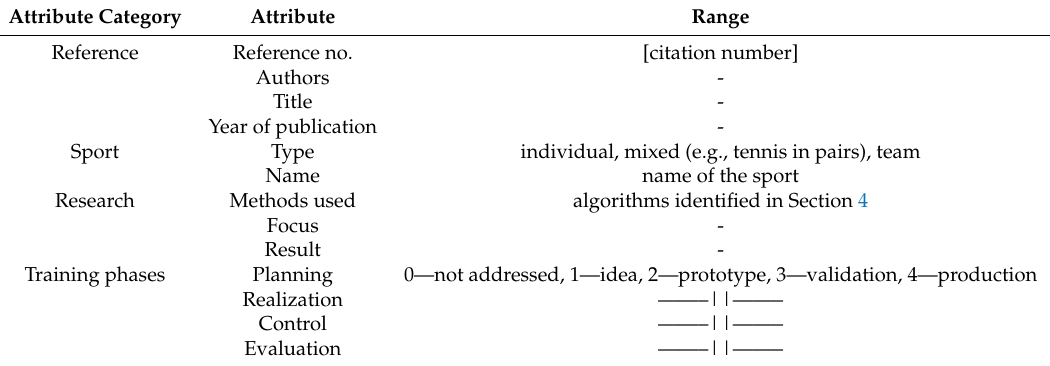
Table 3. Attributes screened in the reviewed studies.